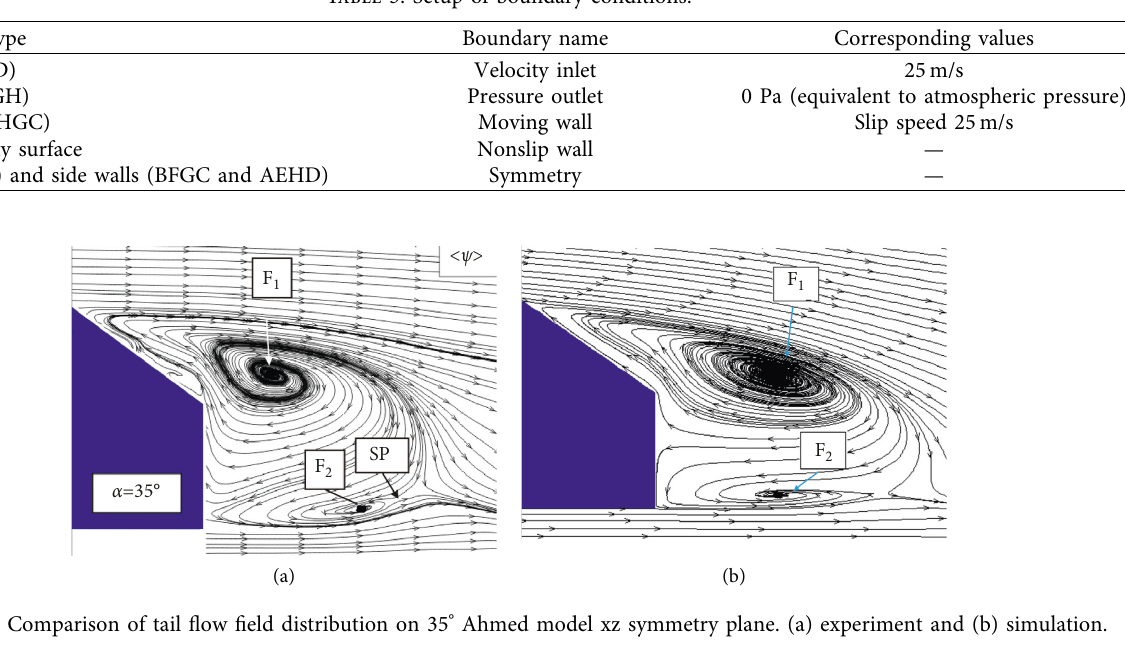
D /C D0 ( C D0 drag value of a